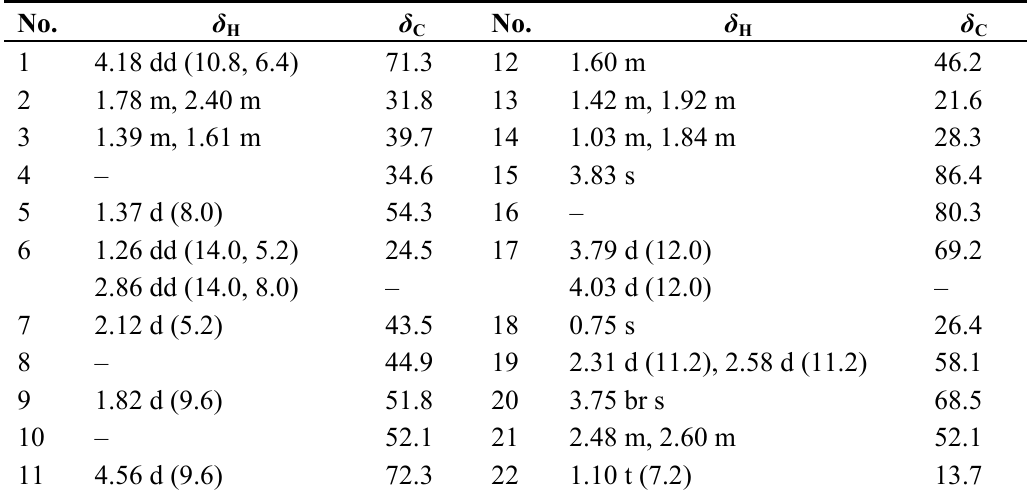
Table 1. 1 H- (400 MHz) and 13 C-NMR (100 MHz) data of 1 (in CD